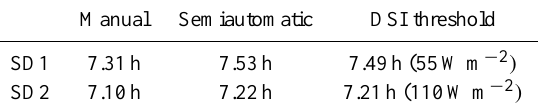
Table 1. The first two columns are the mean value of SD by manual and semiautomatic methods, respectively. The third column is the value of SD from pyrheliometric method by using a DSI threshold (in parenthesis) that would approach the corresponding mean SD using the semiautomatic method. Recall that the “true” mean SD (by using 120Wm − 2 as the DSI threshold) is 7.16h.